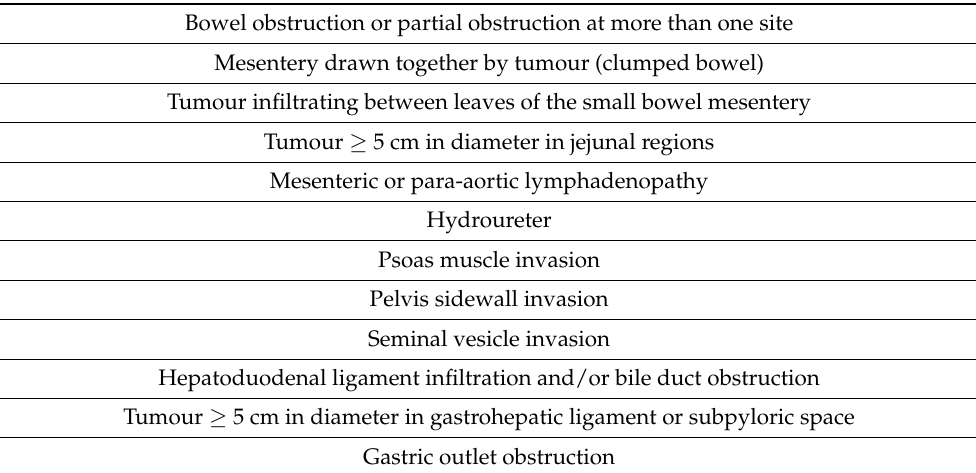
Figure 12. Patient in study for right adnexal mass. T2WI axial ( A ) and postGd DIXON axial ( C ) MR images of the pelvis show a markedly heterogeneous right adnexal mass with necrotic/cystic changes (arrows). DWI b1000 coronal ( B ) and T2WI axial ( D ) MR images of the upper abdomen show an abnormal thickening with restricted diffusion of the greater curvature of the gastric body (dotted arrows), suggesting the probable metastatic nature of the adnexal mass. Primary signet cell type gastric adenocarcinoma with ovarian metastases was confirmed. Table 1. Imaging features associated with an increased risk of incomplete tumour resection, according to Sugarbaker